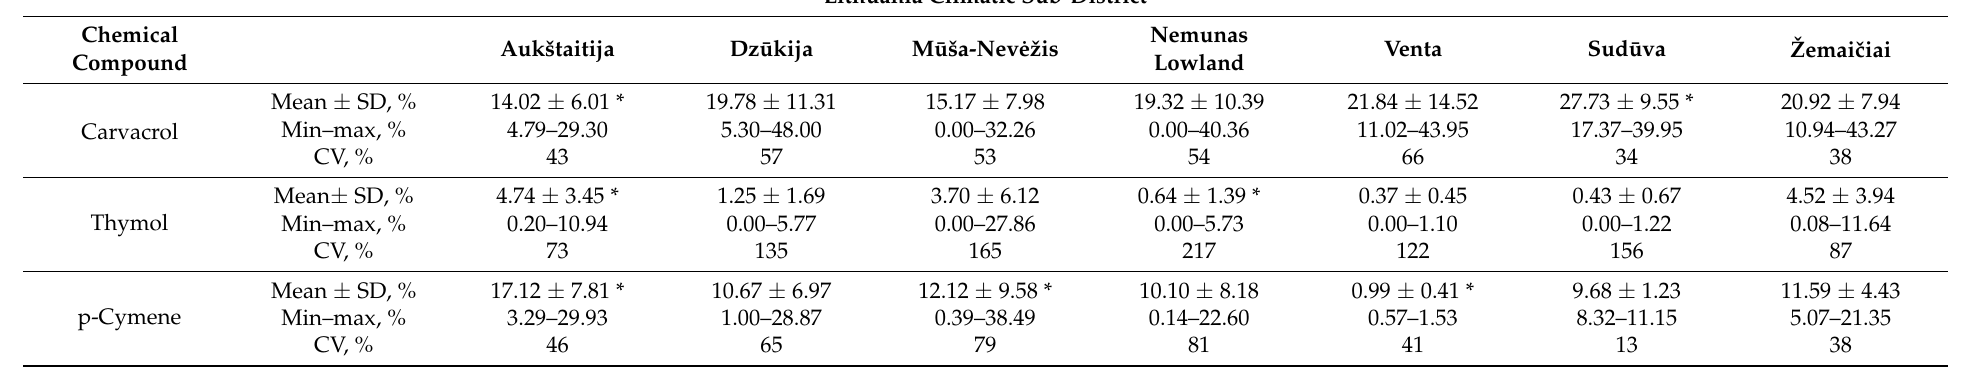
Table 7. Descriptive statistics of the main chemical compounds in Thymus pulegioides essential oils in different sub-districts of Lithuania. * denote statistically significant ( p < 0.05) differences, ** denote statistically significant differences between habitats of Aukštaitija and the Nemunas Lowland climatic sub-districts by amount of